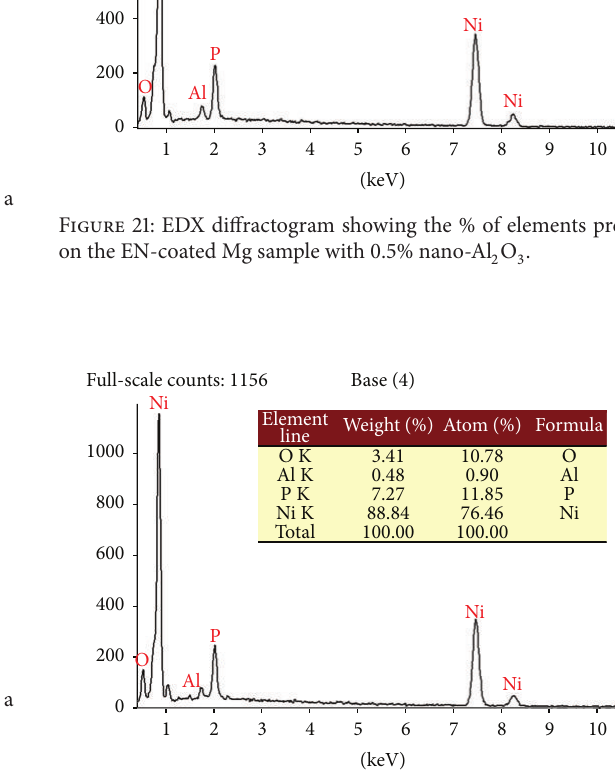
Figure 22: EDX diffractogram showing the % of elements present on the EN-coated Mg sample with 2% nano-Al 2 O 3 .